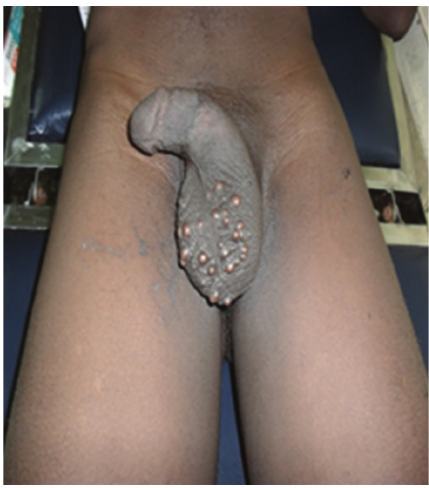
Figure 1: Multinodular lesions of scrotal skin.